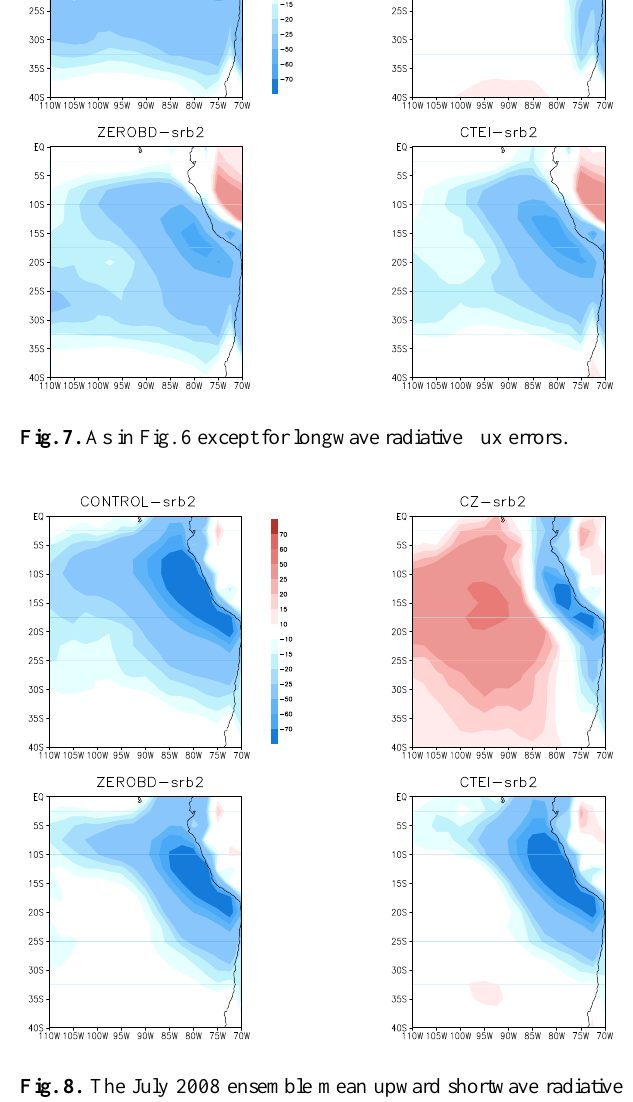
Fig. 8. The July 2008 ensemble mean upward shortwave radiative flux errors (difference between the simulations and SRB climatol- ogy) at the top of the atmosphere in the four